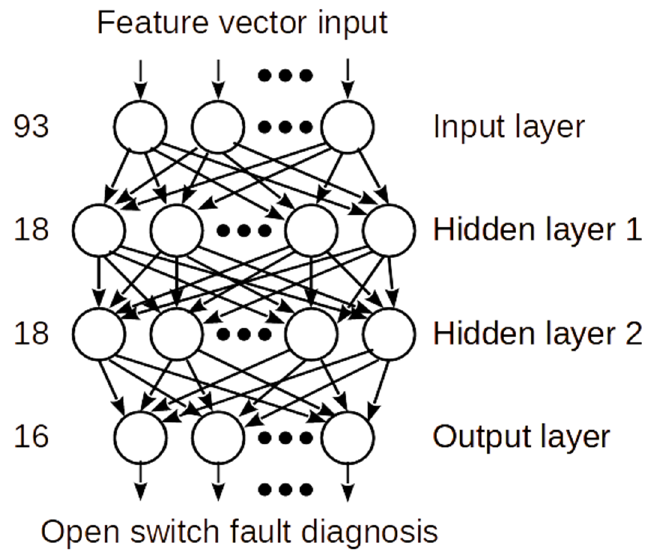
Figure 3. MLP structure for current fault detection and